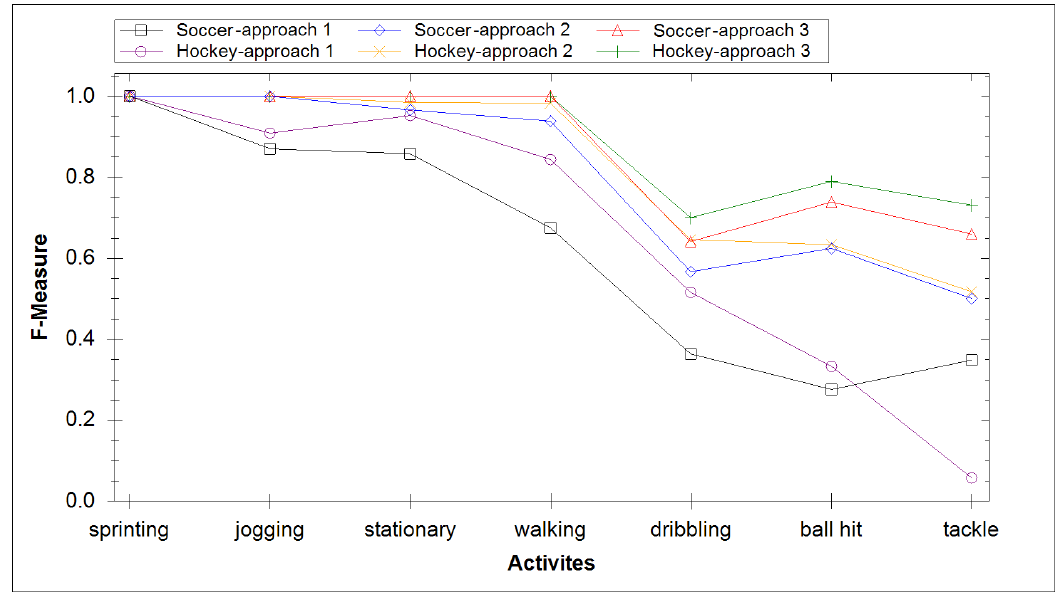
Figure 9. Single activity accuracy results for each approach.